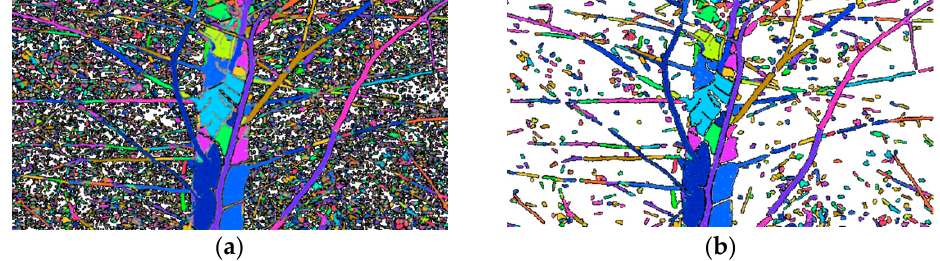
Figure 6. Generating a wireframe model. ( a ) Estimation of the distance between neighbor points; ( b ) edges between neighboring points (a wireframe model).